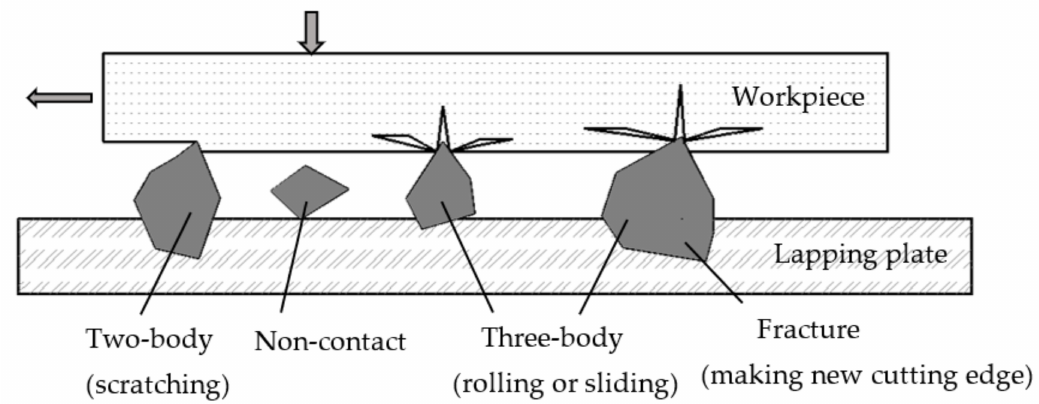
Figure 3. Schematic diagram of free abrasive processing and removal mechanism.